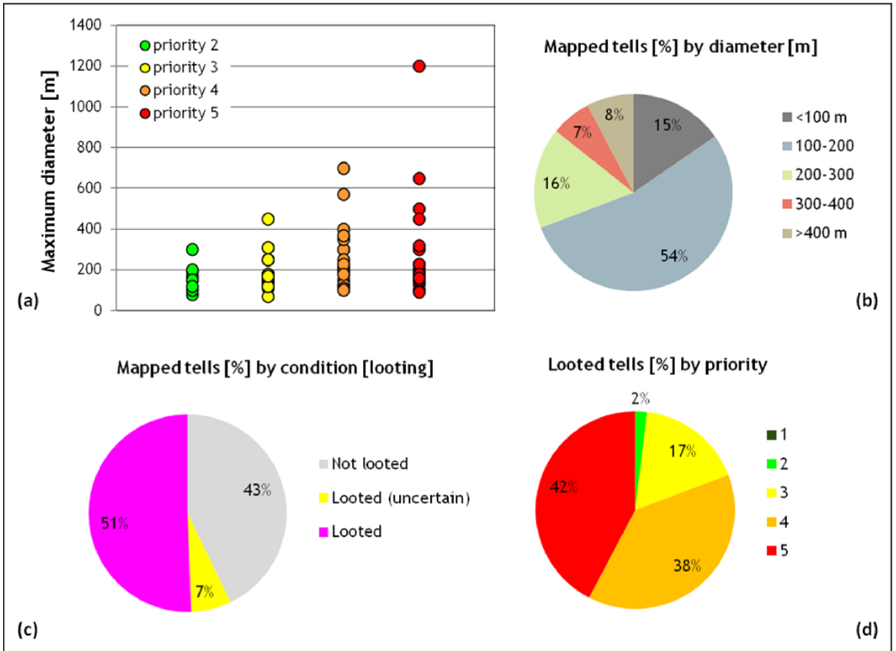
Figure 11. Statistics of the mapped tells by: ( a ) size (i.e., maximum diameter) vs. archaeological priority, ( b ) size class, ( c ) condition (i.e., as assessed through visual interpretation of satellite imagery), and ( d ) looting evidence vs. archaeological priority.